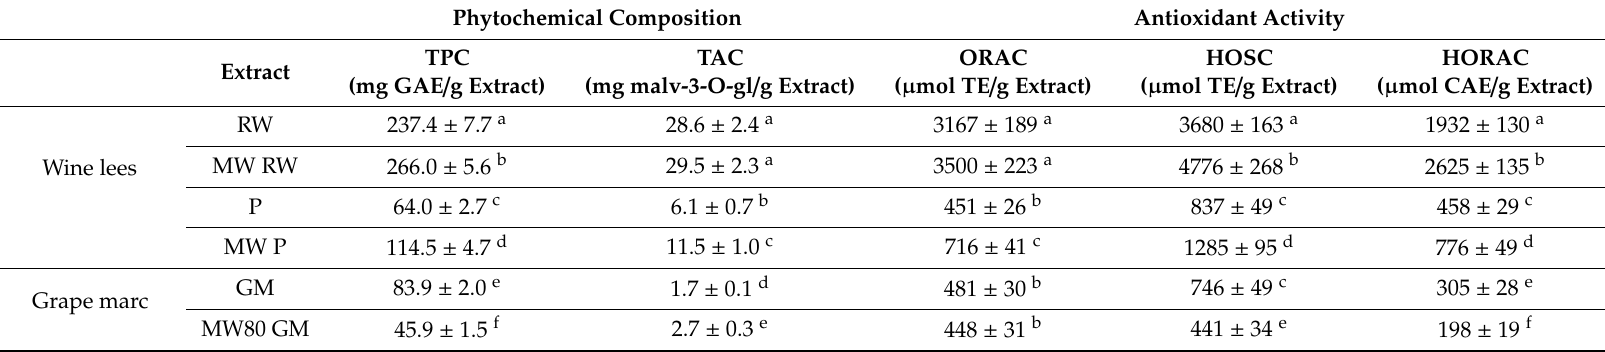
Table 1. Phytochemical composition and antioxidant activity of the extracts. The results identified with di ff erent letters (a to f) in the same column are statistically di ff erent ( p -value ≤